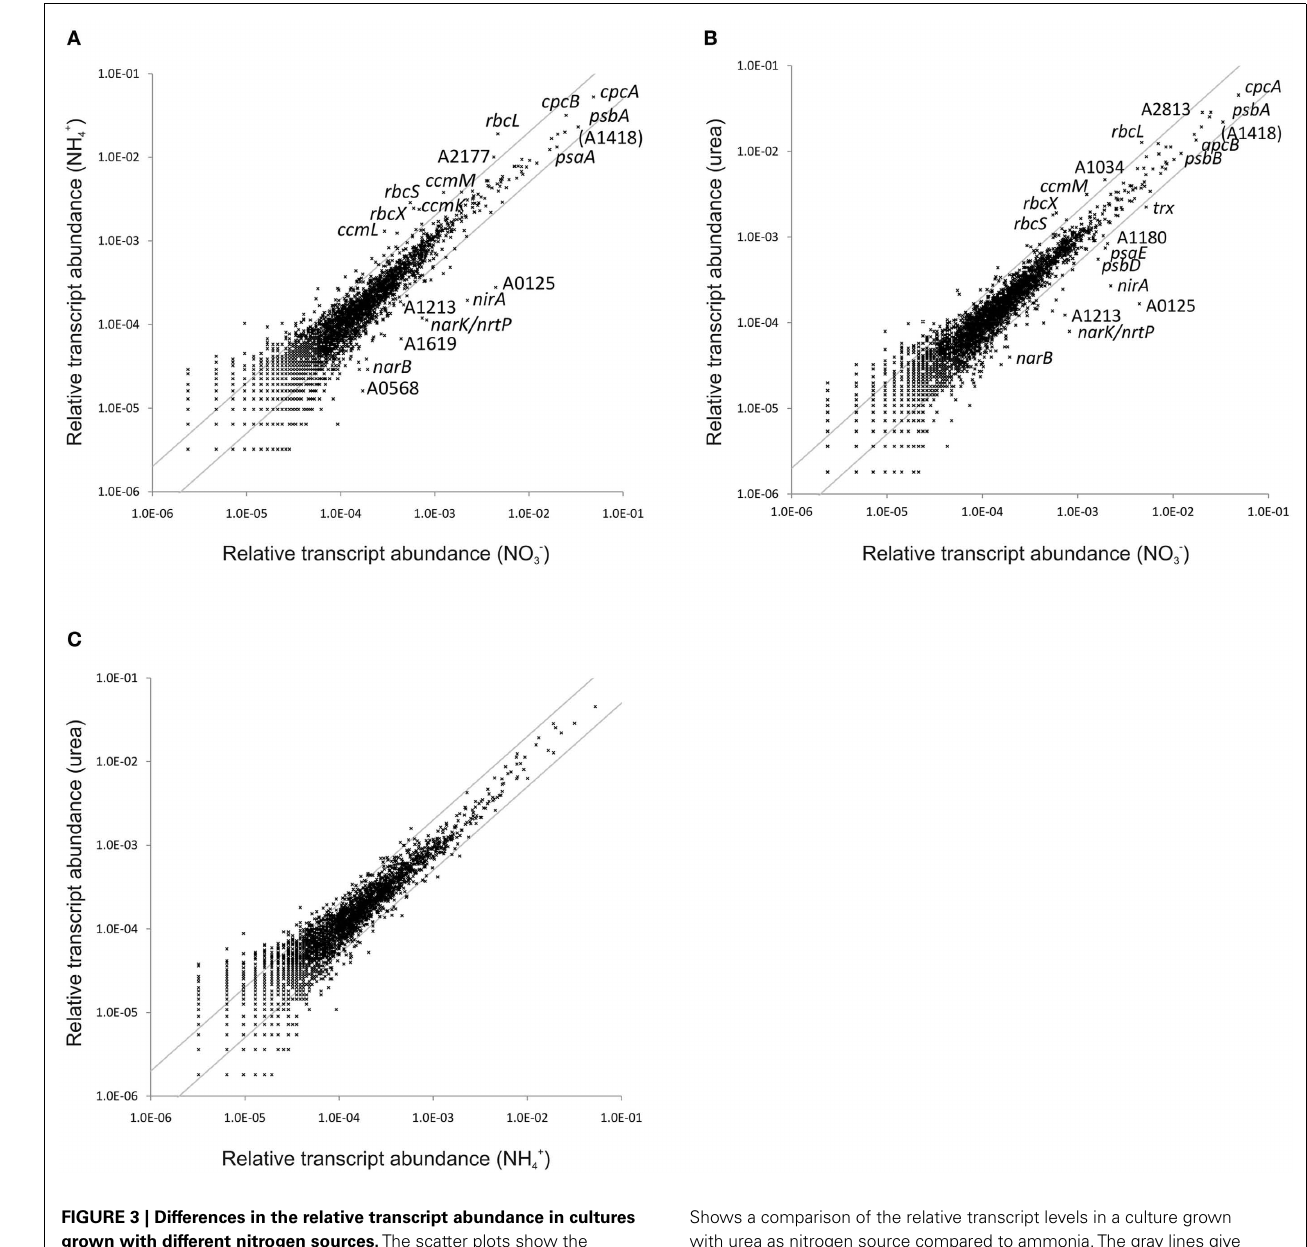
Shows a comparison of the relative transcript levels in a culture grown with urea as nitrogen source compared to ammonia.The gray lines give 2-fold changes in either direction. Selected genes are identified by name/locus tag